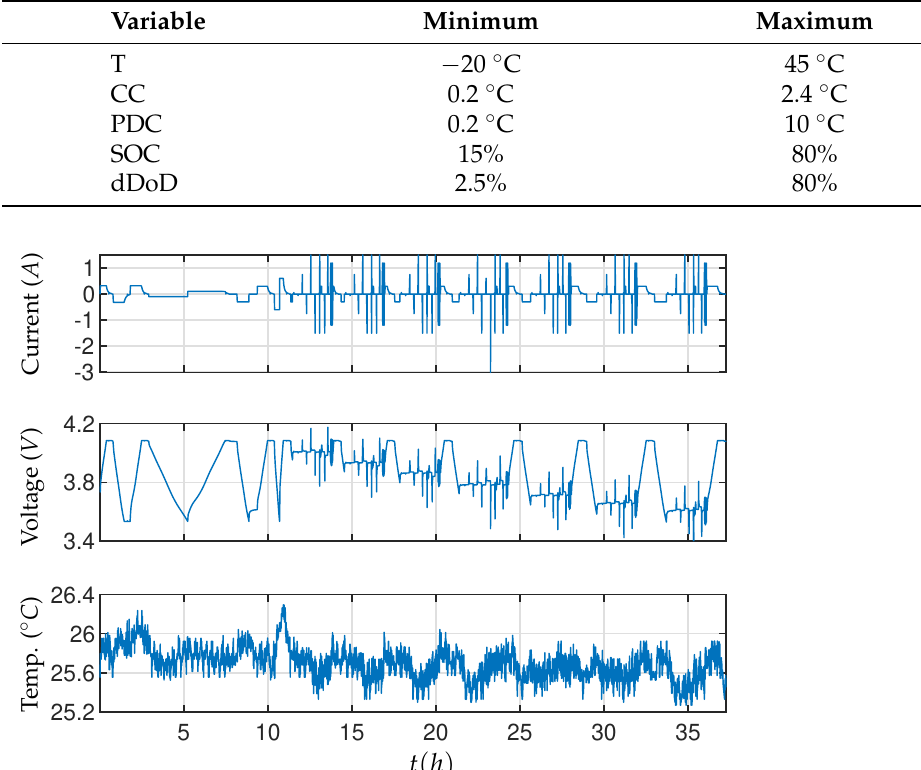
Table 2: Impact factors for the accelerated ageing tests